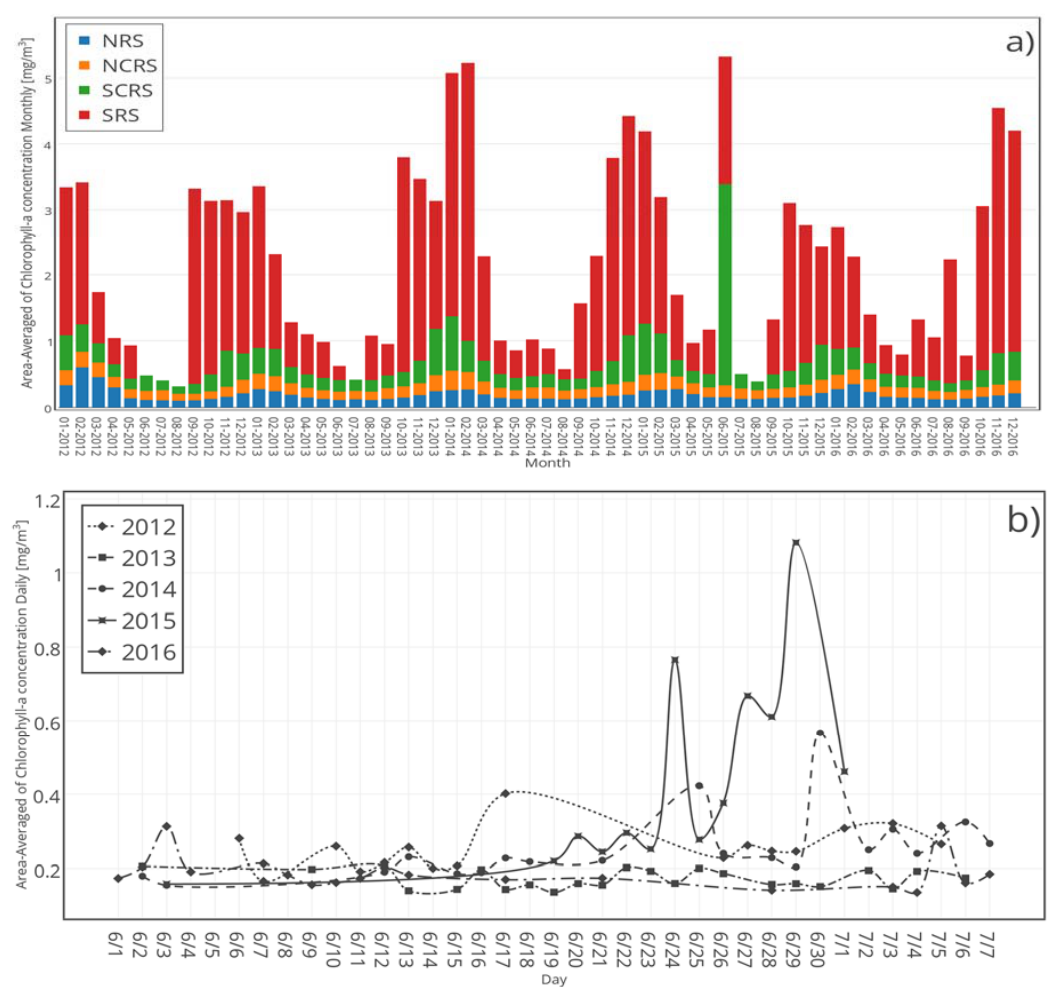
Figure 3. Time series analysis of chlorophyll- a concentration in the Red Sea. ( a ) Area average of MODIS Aqua Chl- a concentration (mg m − 3 ) monthly data from January 2012 to December 2016 over four regions of Red Sea ( b ) South Central Red Sea daily OC-CCI Chl- a concentration (mg m − 3 ) from 1 June to 7 July for each year from 2012 to 2016.